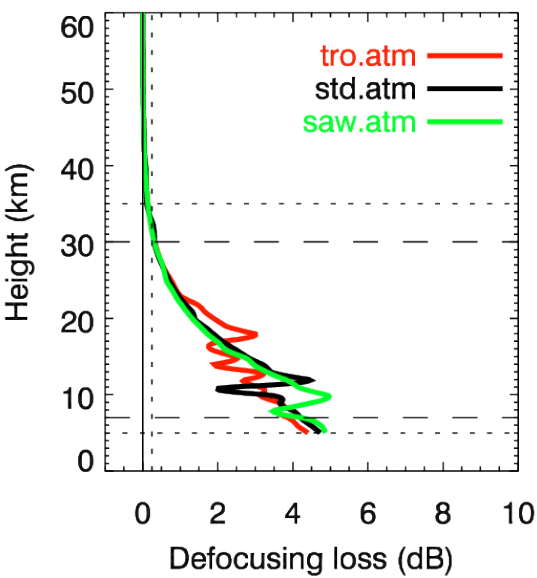
Fig. 3. Defocusing loss for SWIR channels in the FASCODE SAW (green), STD (black), TRO (red) atmospheres. The vertical dotted line marks the boundary of the lower useful-signal limit of 0.25 dB . The horizontal dotted and dashed lines mark target and threshold requirements, respectively, regarding the vertical range within which trace species shall be retrieved (Kirchengast and Schweitzer,